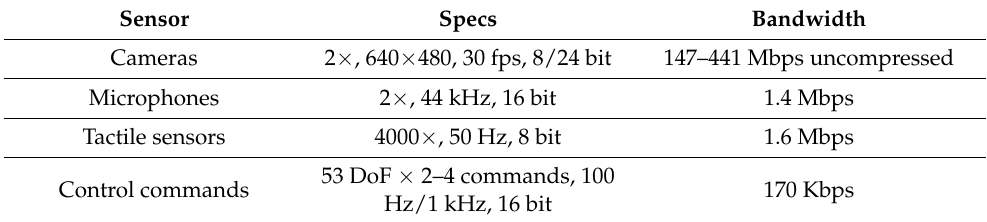
Table 1. Requirements for sensors and signals.